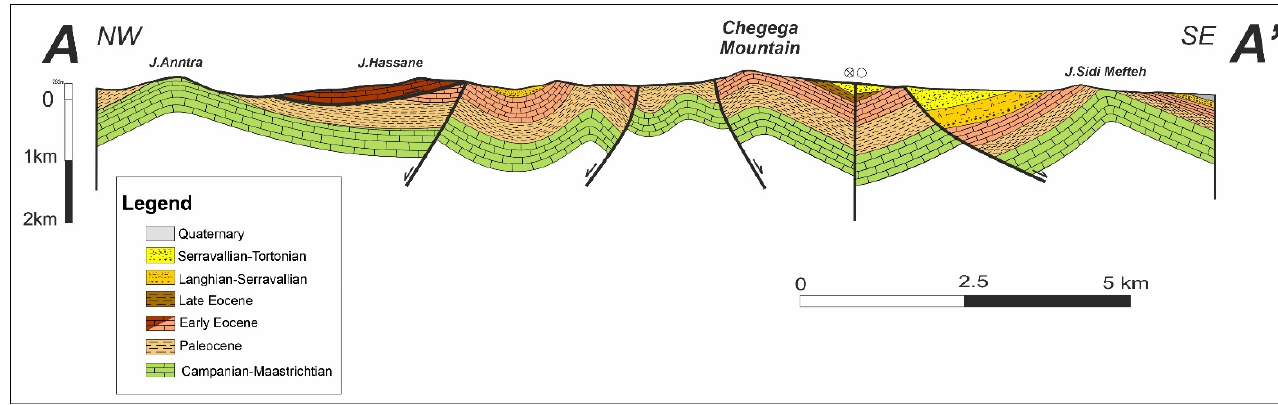
Figure 3. NW-SE cross-section highlighting the main structures of the study area (AA’). Position of AA’ is given in Figure 2.